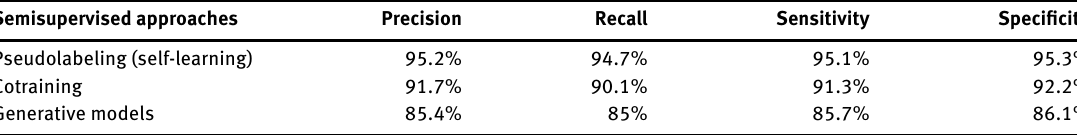
Table 2: Accuracy Measures on Validation set for Semisupervised